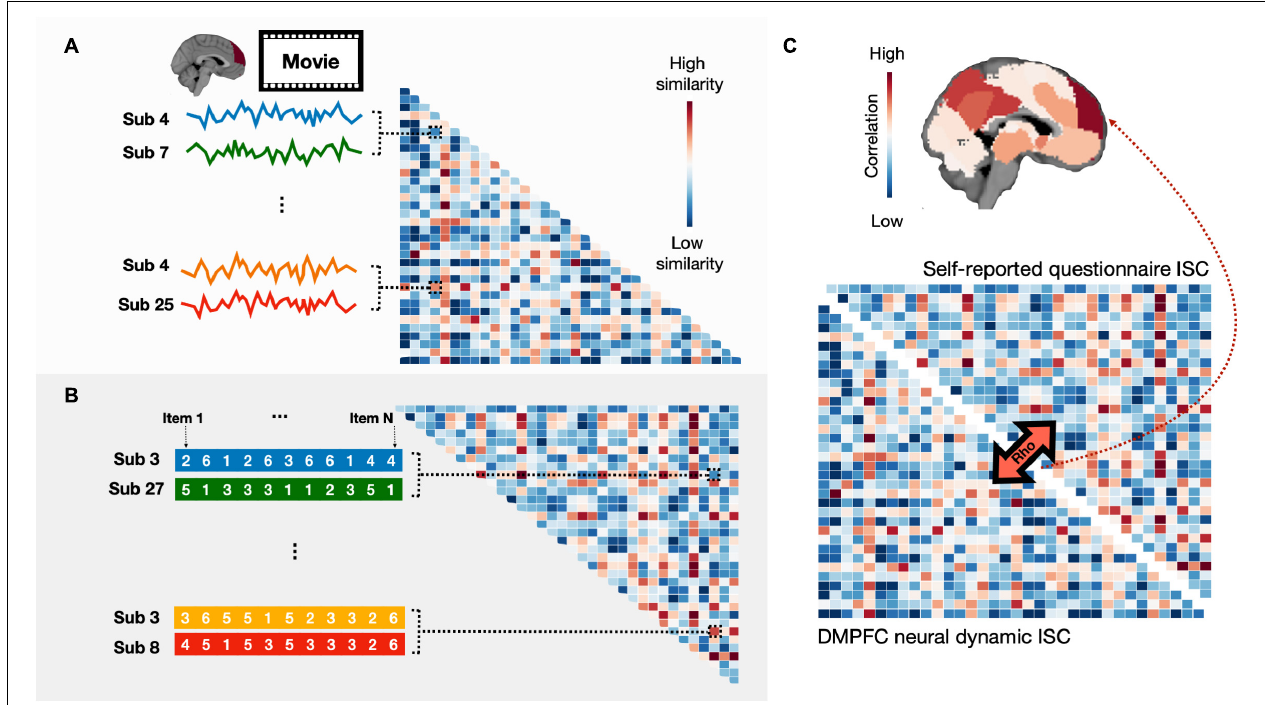
FIGURE 1 | Intersubject correlation (ISC) and intersubject representational similarity analysis (IS-RSA). IS-RSA involves (A) computing an ISC, which yields a subject by subject correlation matrix using mean neural responses within an ROI (e.g., DMPFC) for a movie, (B) computing another ISC, which yields a subject by subject correlation matrix using item-wise responses for self-reported questionnaires (e.g., parenting beliefs), and (C) conducting a spearman rank correlation between the two correlation matrices. In this case, intersubject variability in the DMPFC is well captured by intersubject variability in parenting beliefs.